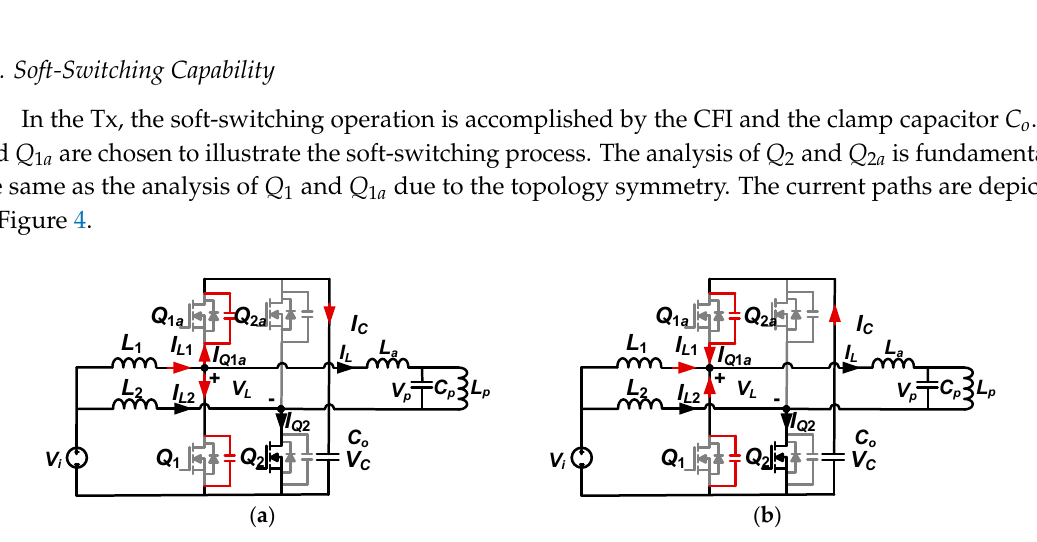
Figure 4. Current paths for CFI conducting ZVS ( a ) state before Q 1 a is on t 0 ~t 1 ; ( b ) state before Q 1 is on t 2 ~t 3 .